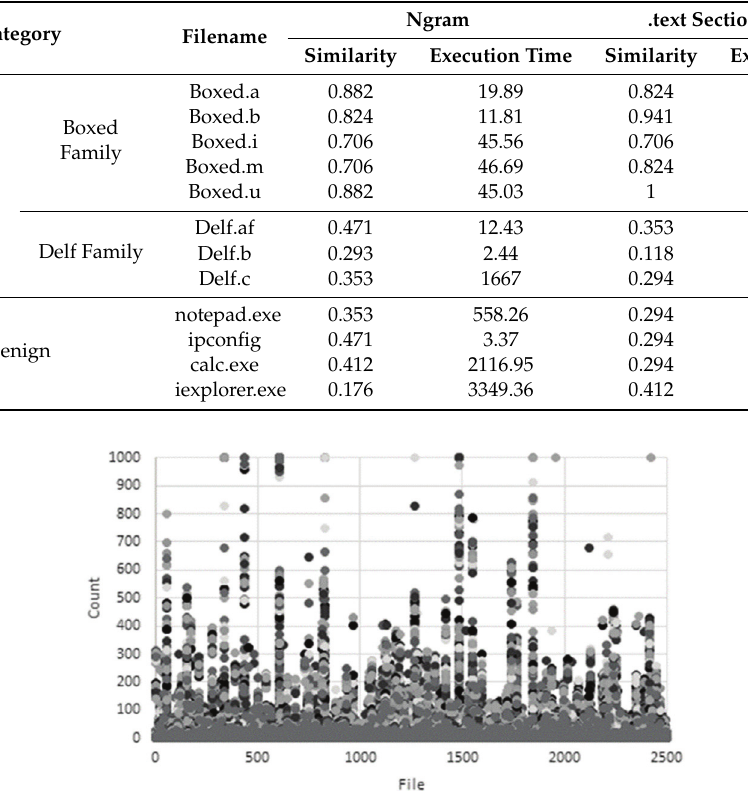
Figure 3. String-based distribution analysis (benign).